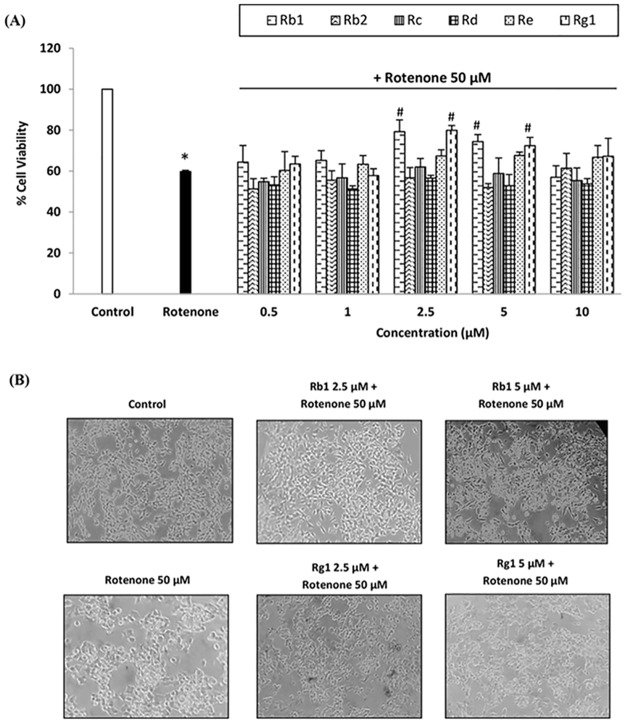
Cytoprotective effects of ginsenosides.(A) Cytoprotective effects of six ginsenosides in SH-SY5Y cell line against rotenone-mediated toxicity (range of concentrations: 0.5–10 μM), assessed by MTT reduction assay. Cells were pre-treated with ginsenosides for 24 h and then exposed to rotenone 50 μM for other 24 h. The viability of control cells was normalized to 100%. Means ± SD, * p < 0.05 Vs control, # p < 0.05 Vs rotenone. (B) Representative images of the morphological studies conducted on SH-SY5Y cell model with ginsenosides Rb1 and Rg1.